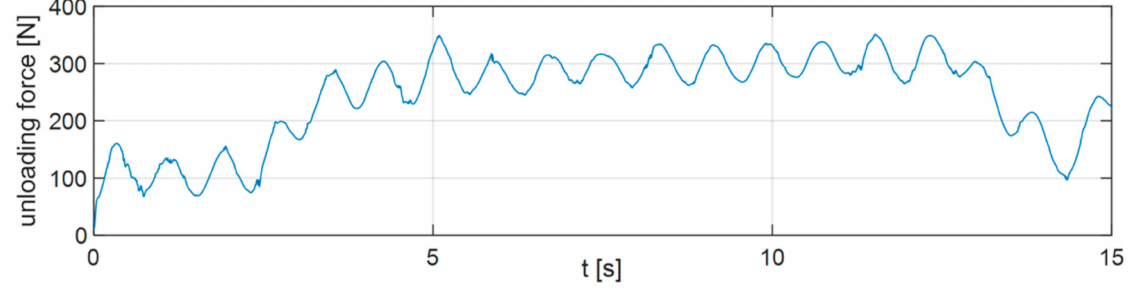
Figure 22. Value of the trainee’s unloading force as a function of